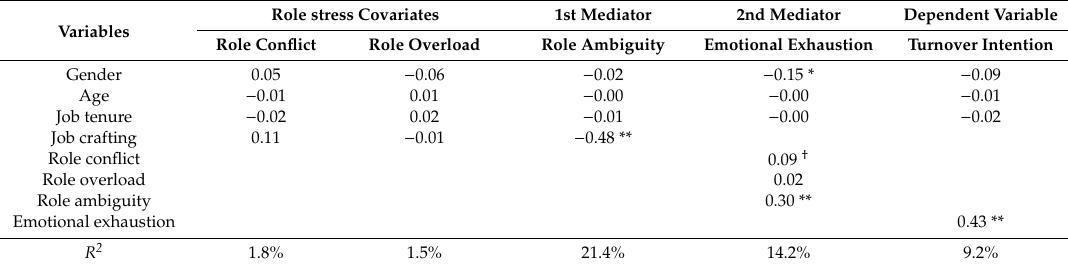
Table 4. Results of path